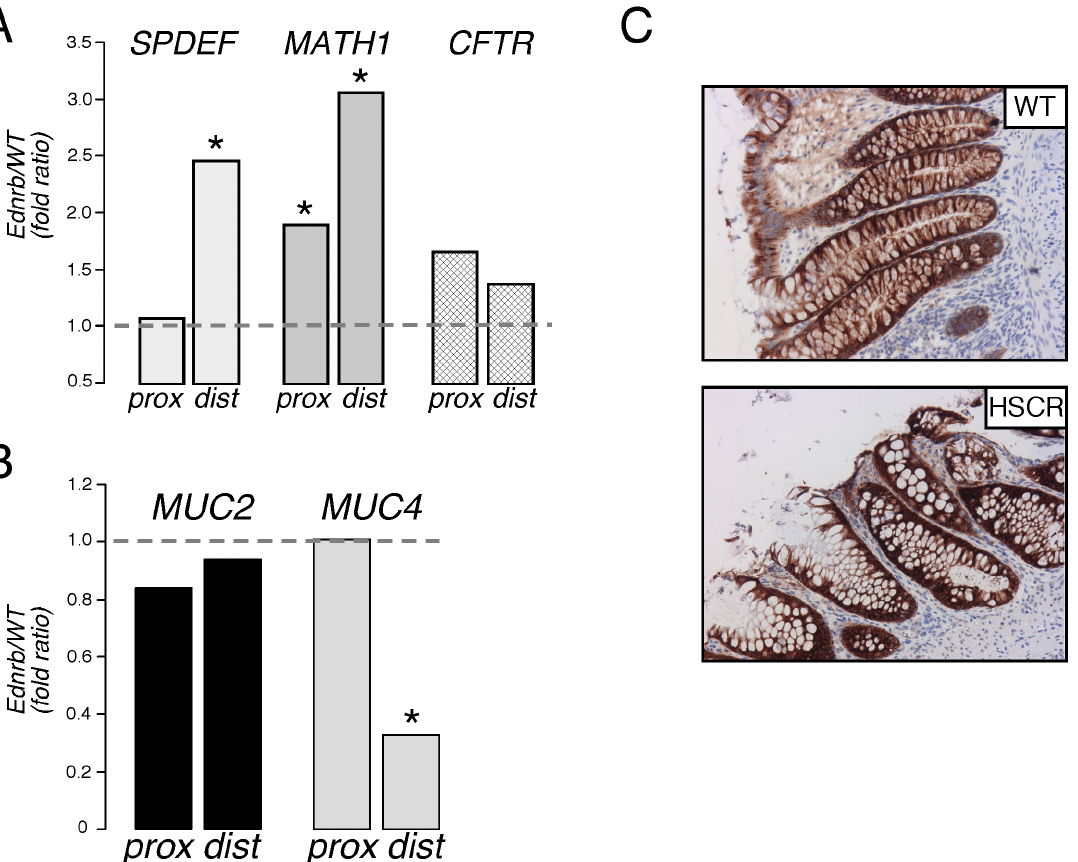
Figure 4. Goblet cell gene expression. A. Muc2 and Muc4 expression by qPCR in mouse proximal (prox) and distal (dist) colon. Data are shown as expression in Ednrb 2 / 2 mice relative to WT mice (n=3). Dotted line (ratio=1) indicates equivalent expression. B. SPDEF, MATH1, and CFTR transcript expression in mouse colon. C. Representative images show Muc4 staining of crypt cells from control and HSCR colon. *p , 0.05.